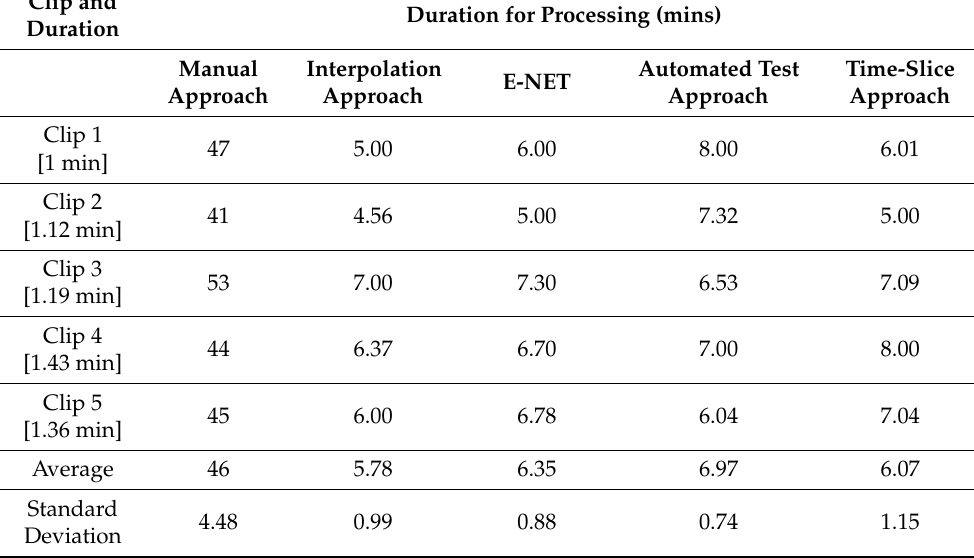
Table 4. Comparison of the proposed interpolation approach with other